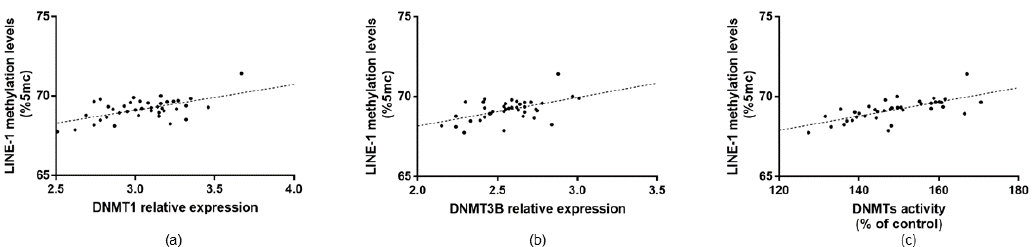
Figure 4. Linear regression analysis of LINE-1 methylation level with DNMTs functions. ( a , b ) LINE-1 methylation level was positively associated with DNMT1 ( r = 0.579; p < 0.001) and DNMT3B ( r = 0.521; p = 0.001) expression. ( c ) In line with increased gene expression, LINE-1 methylation level was also positively associated with total DNMTs activity ( r = 0.694; p < 0.001). LINE-1, Long Interspersed Nuclear Element-1; DNMT, DNA methyltransferases.